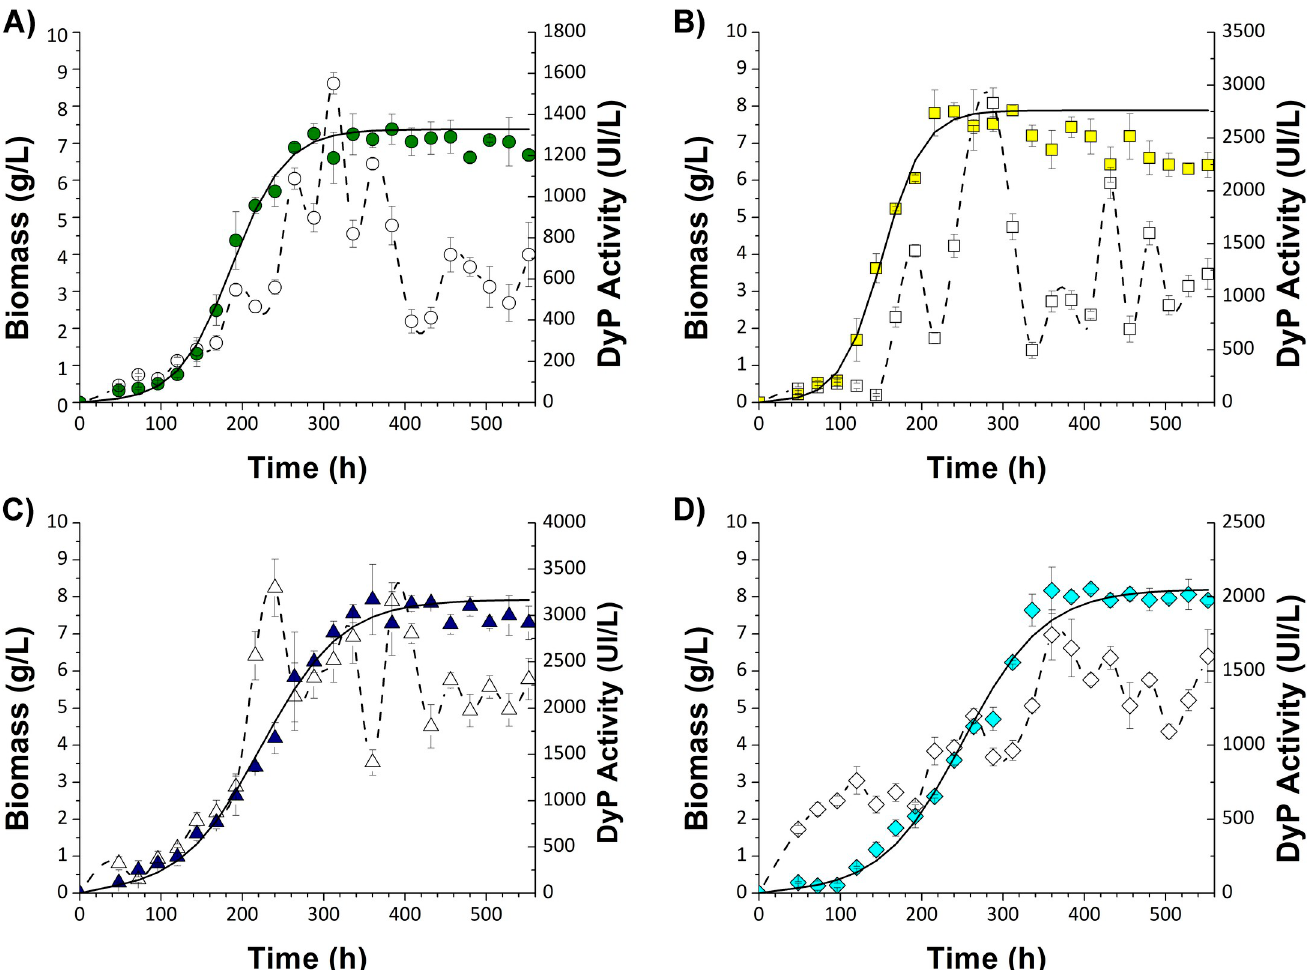
Fig 1. Growth of Pleurotus ostreatus and Pleos-dyP activity. Pleorutus ostreatus was grown on submerged fermentation in a control media (A) and in the presence of 500 ppm of different dyes– (B) AYG, (C) RBBR, and (D) AB129. Time course of extracellular DyP activity (open symbols) and P . ostreatus biomass (colored closed symbols). Bars show standard